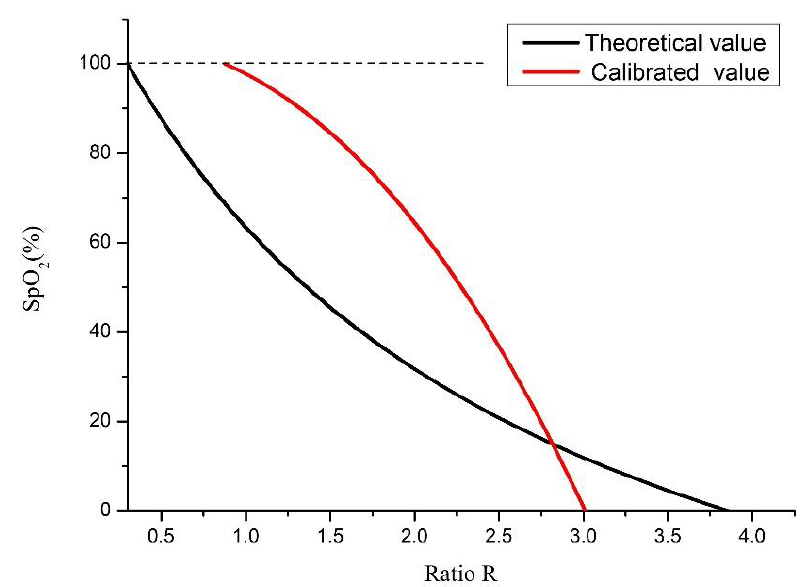
Figure 5. Relationship between the oxygen concentration value and R value. Table 1. The extinction coefficients (Lmmol −1 cm −1 ) of the reduced ( εH b ) and ( εH b O 2 ) oxygenated he- moglobin at the wavelengths of 660 nm and 905 nm.